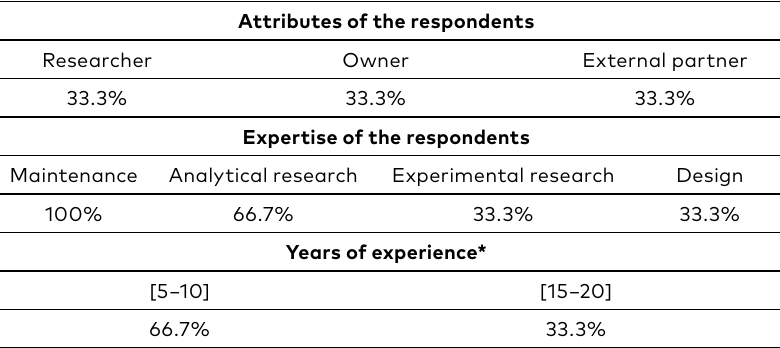
Table 1. The identity of the questionnaire